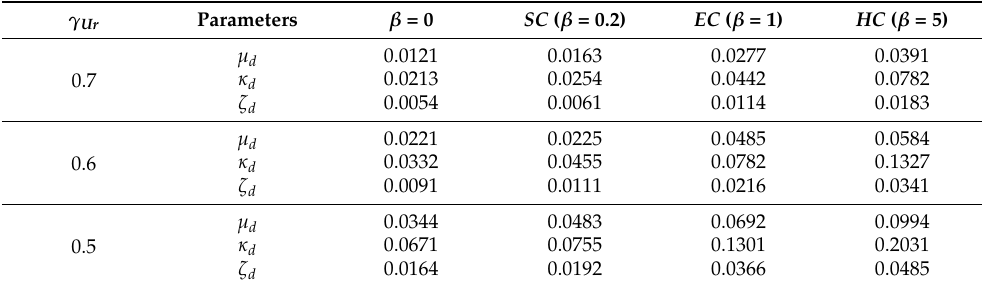
Table 2. Optimal parameters of CIVD.